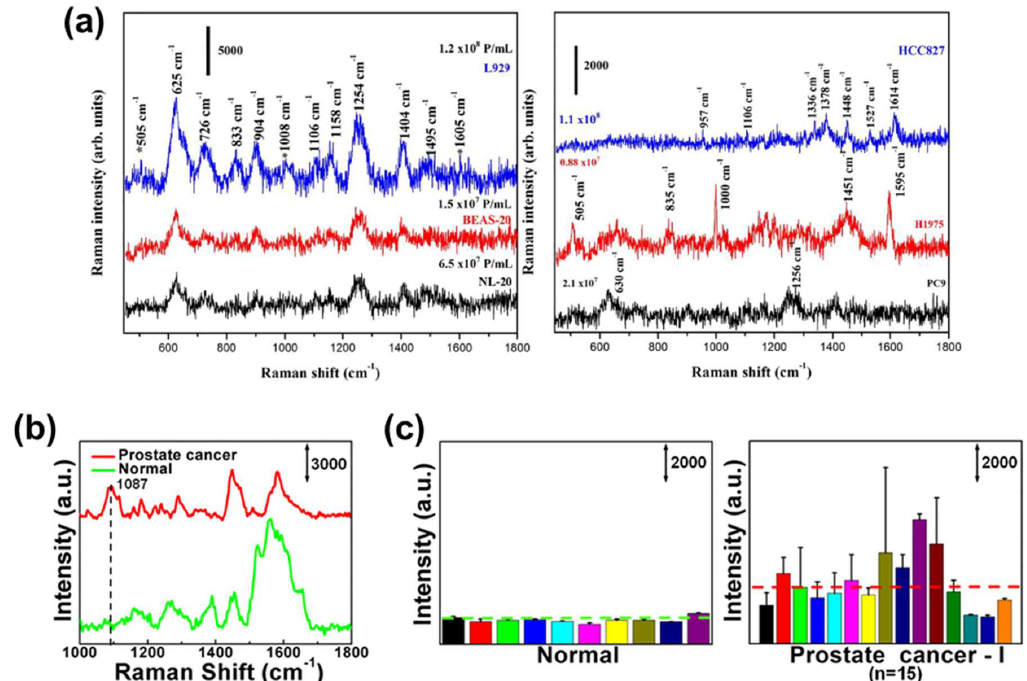
Figure 8. Specific bands-based EV-derived signal analysis. ( a ) The signal difference between normal lung cell line-derived EVs (NL-20, BEAS-20, and L929) and lung cancer cell lines-derived EVs (PC-9, ( b ) The signal di ff erence at the Raman band is associated with protein phosphorylation (P-O bond) between healthy cell- and prostate cancer cell-derived EVs. ( c ) Prostate cancer patients’ EVs tend to show higher protein phosphorylation status in the SERS result. Adapted with permission from Ref. [50]. Copyright 2020 American Chemical